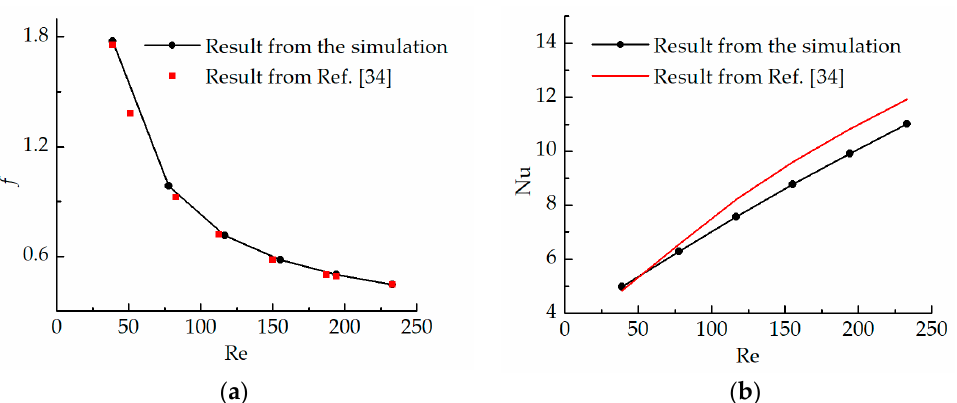
Figure 2. Numerical validation of the simulation method with the results from [34]: ( a ) f versus the Reynolds number Re; ( b ) Nu versus Re.